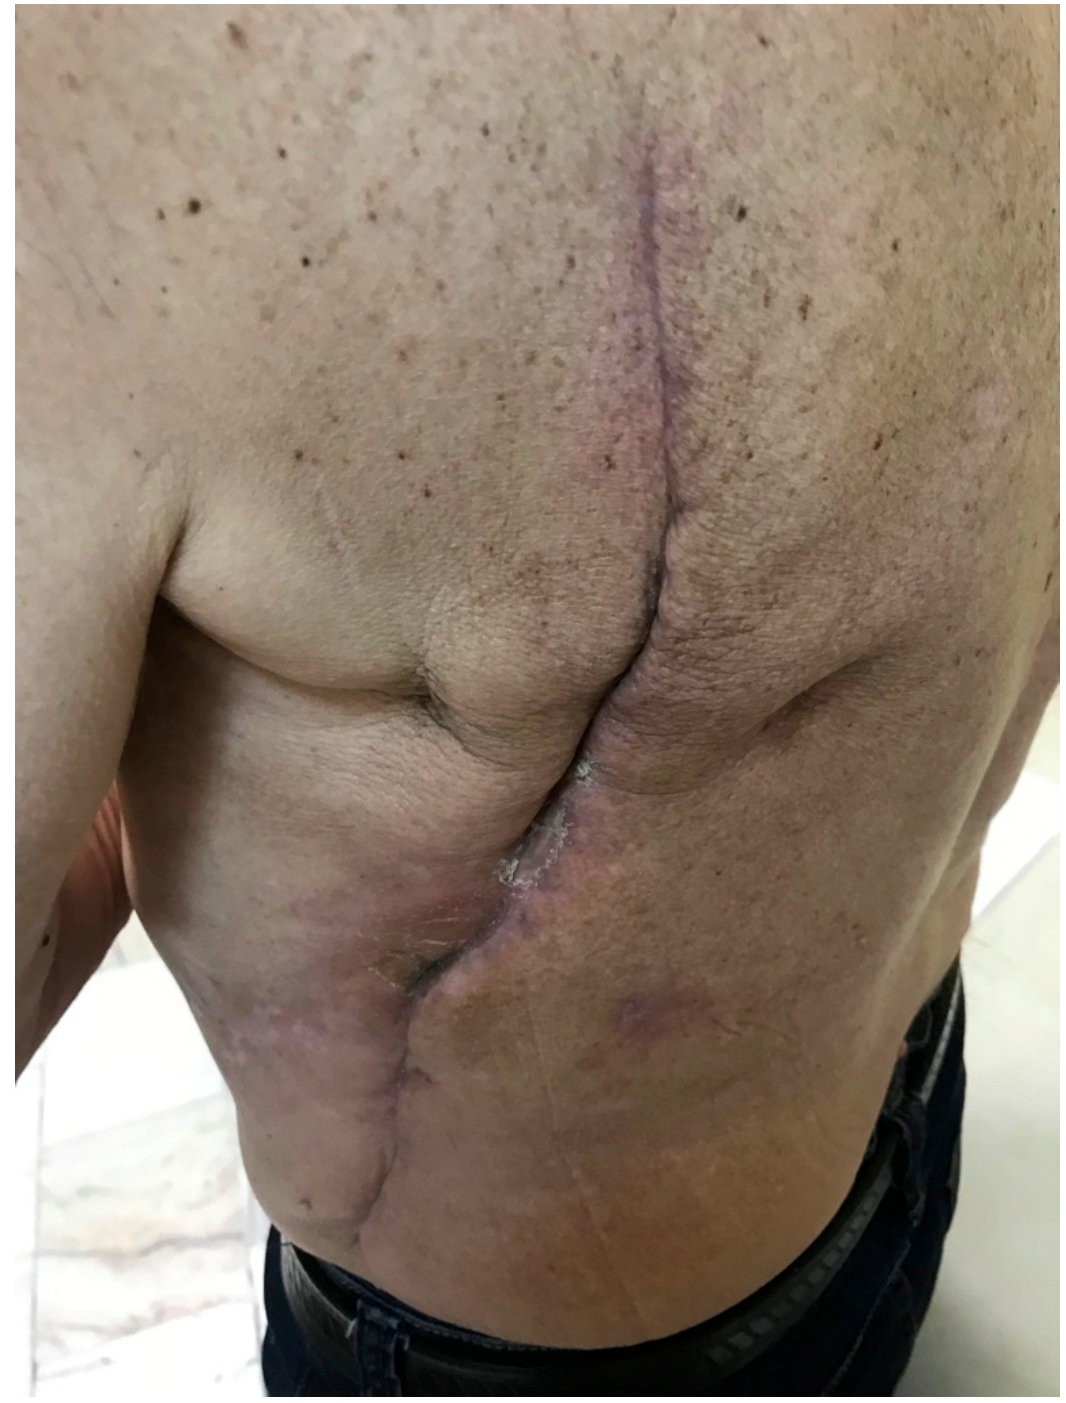
Figure 2. Grade 1 chronic radiation dermatitis.